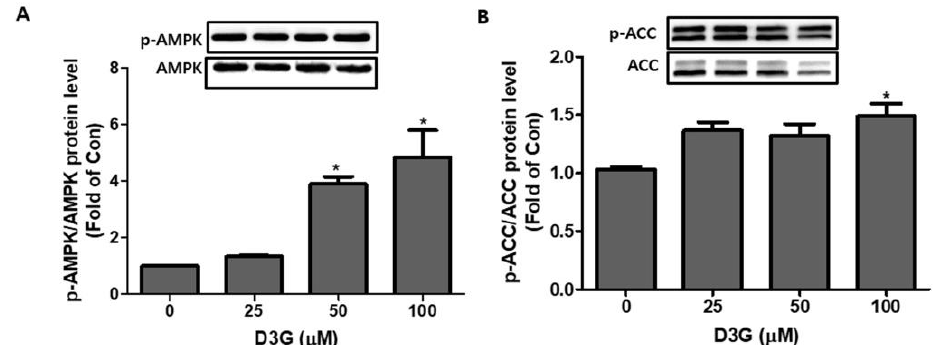
Figure 6. The effect of delphinidin-3- O - β -glucoside (D3G) treatment (25, 50, and 100 µM) on the expression and phosphorylation of adenosine monophosphate-activated protein kinase (AMPK) and acetyl-CoA carboxylase (ACC) in primary white adipocytes (PWATs). D3G treatment increased the expression of (A) p-AMPK/AMPK and (B) p-ACC/ACC in PWATs when compared to the control (0). * p < 0.05 vs. 0. Each experiment was repeated three times and the data represent the mean ±